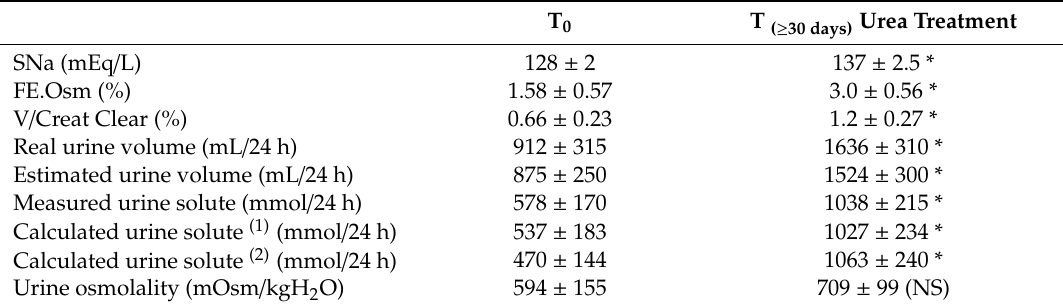
* p < 0.01; FE.Osm: 2 ± 0.5% (Normal value); Normal 24 h urine solute output: 720 ± 220 mmol / 24 h; (1) Obtained by eGFR (L / min) × Sosm × 1440 × FE.Osm (in%) (mmol / 24 h); (2) Obtained by eGFR (L / min) × 1440 × V / eCcr (%) × urine osmolality (mmol / 24